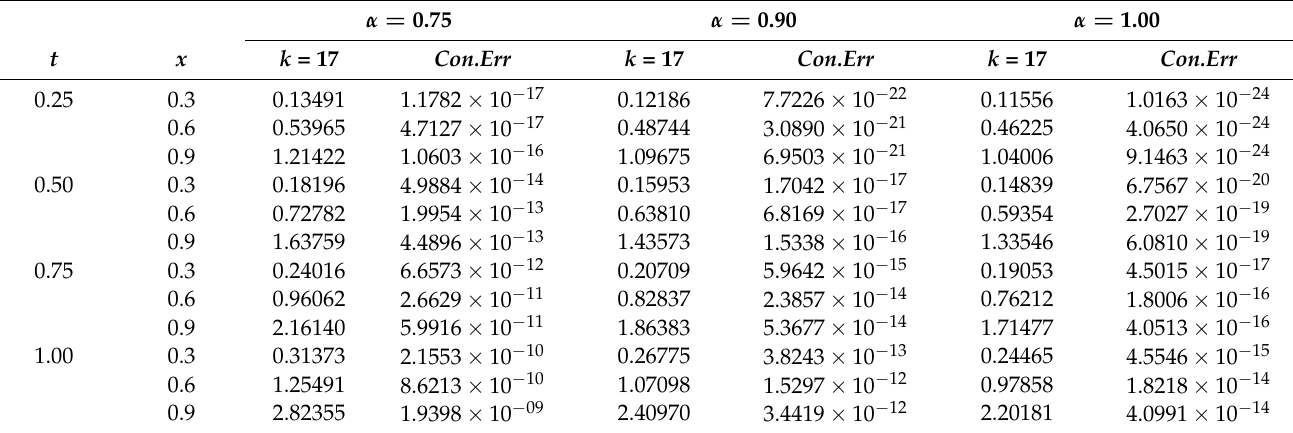
Table 1. The numerical solutions and Con . Err obtained by the L-RPSM for Application 5 at α = 0.75, 0.9, and 1.